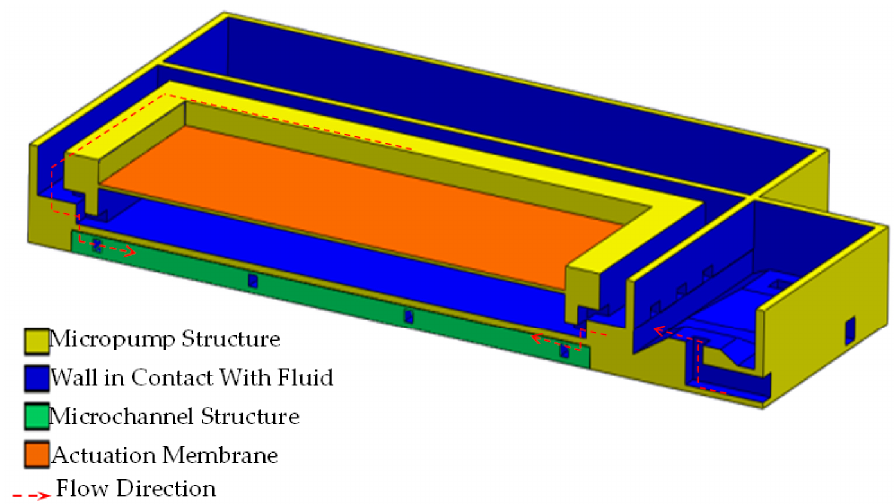
Figure 10. Cross sectional view of the suction process.